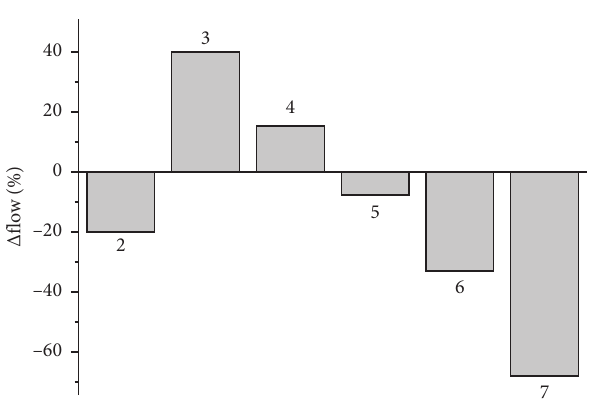
Figure 6: Flow values normalized to flow value of cement paste 1.